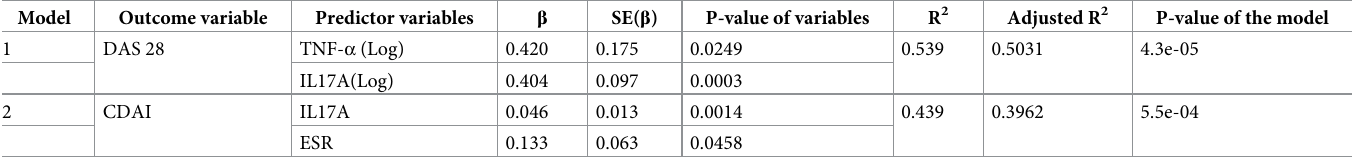
Table 3. Multiple linear regression to assess the association between disease activity (DAS 28 and CDAI) with cytokine expression and ESR. Model Outcome